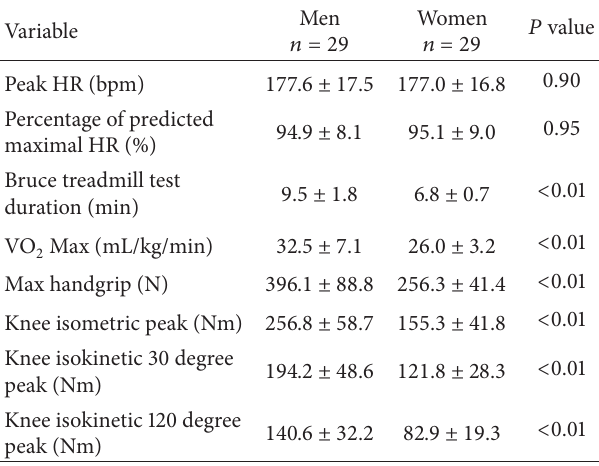
Table 4: Aerobic fitness and indices of strength.